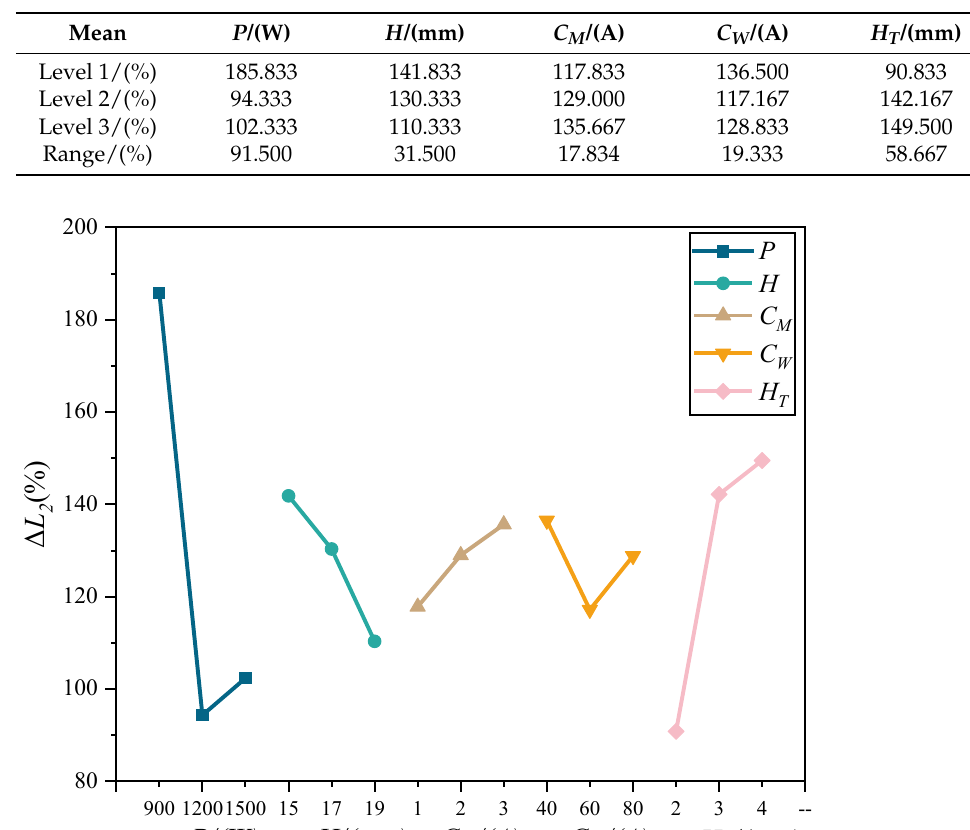
Table 3. Results of the orthogonal experimental analysis of ∆ L 2 .